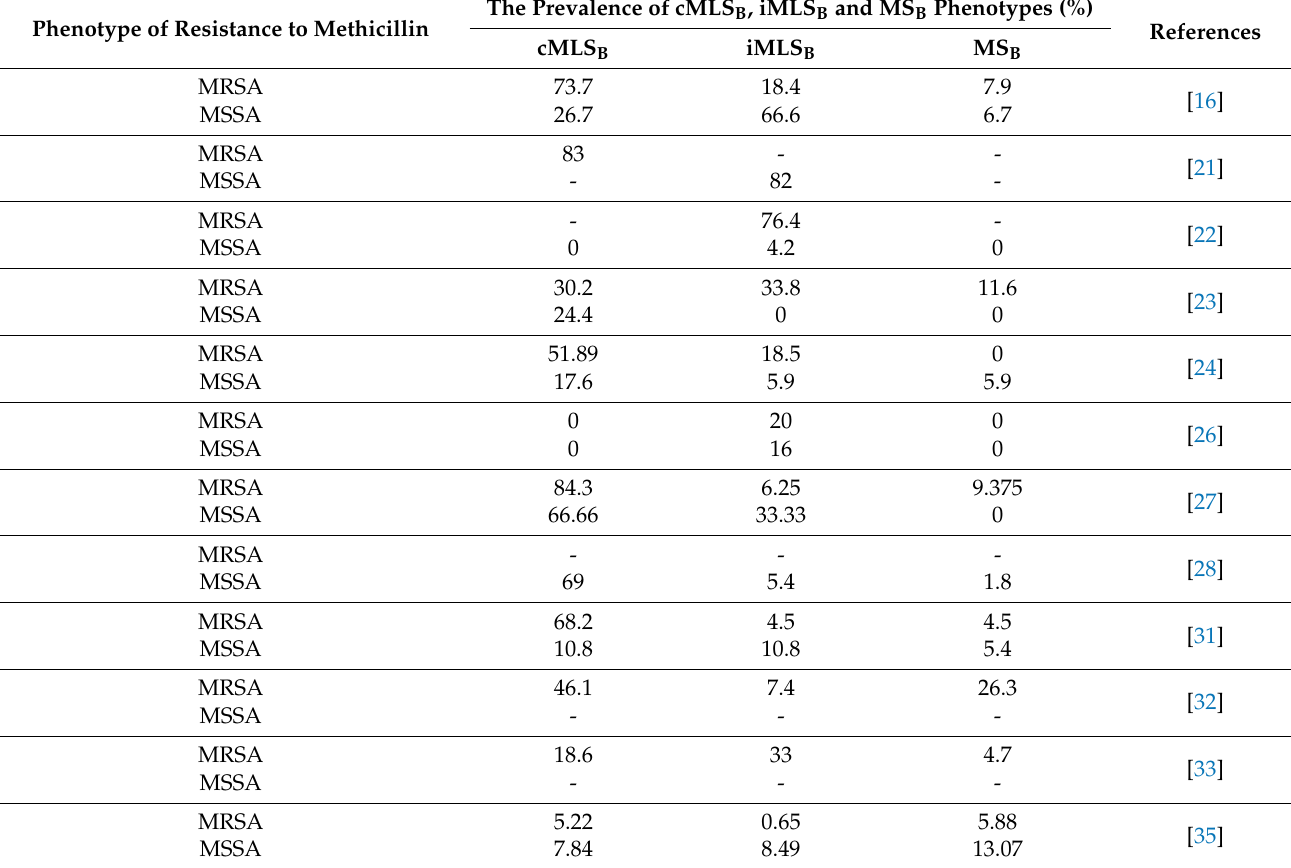
Table 1. Prevalence of cMLS B , iMLS B , and MS B phenotypes (%) among MRSA and MSSA isolates [16,21–24,26,27,31–33,35]. Phenotype of Resistance to Methicillin